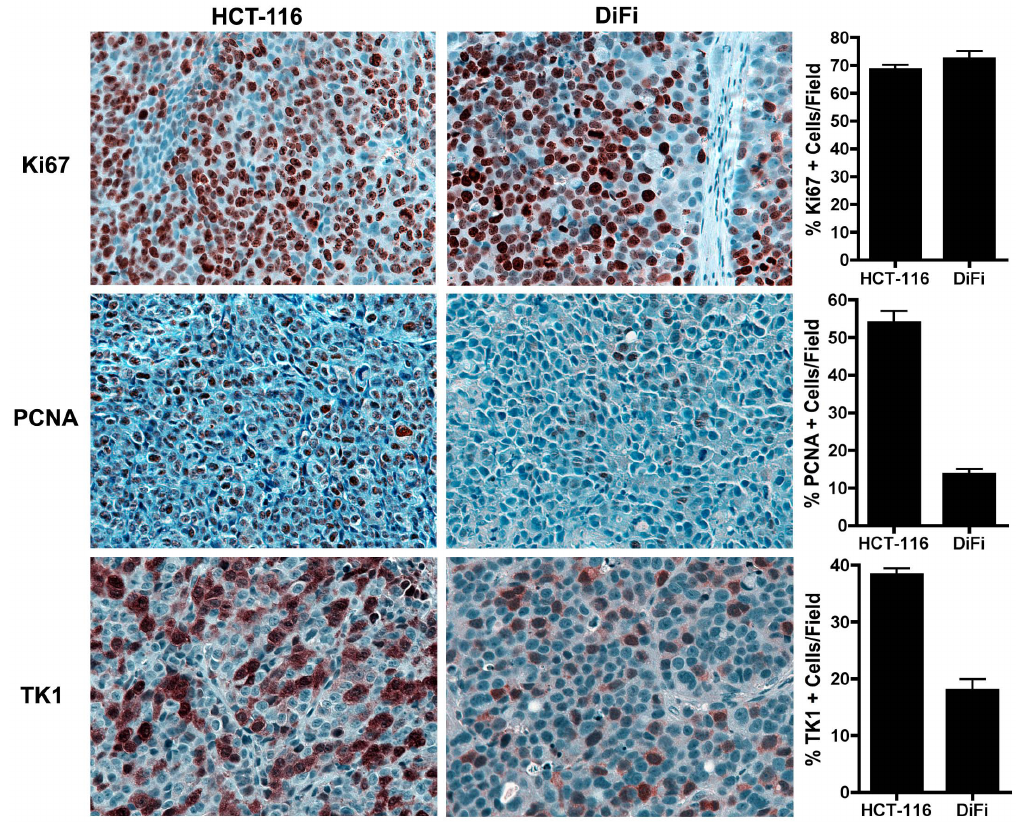
Figure 2. IHC markers of proliferation in HCT-116 and DiFi human CRC xenografts. Representative high power microscopic images (40x) of HCT-116 and DiFi xenograft tissue stained for Ki67, PCNA, and TK1 are shown along with quantification of the percentage of positive cells per field for each marker. HCT-116 and DiFi xenograft tissues exhibit a similar proportion of proliferating cells as measured by Ki67 indices (68.50 6 5.52 % vs. 72.37 6 12.64%; p = 0.0651). The proportion of PCNA positive cells, representing S-phase, was significantly increased in HCT-116 xenografts (53.91 6 3.18 %) compared to DiFi xenografts (13.59 6 1.48%; p = 0.0007). Similar to PCNA, the percentage of TK1-positive cells was significantly higher in HCT-116 xenografts (38.32 6 1.90 %) than DiFi cells (17.95 6 3.95 %; p = 0.0007). TK1 indices for both cell lines were reduced compared to Ki67 indices.